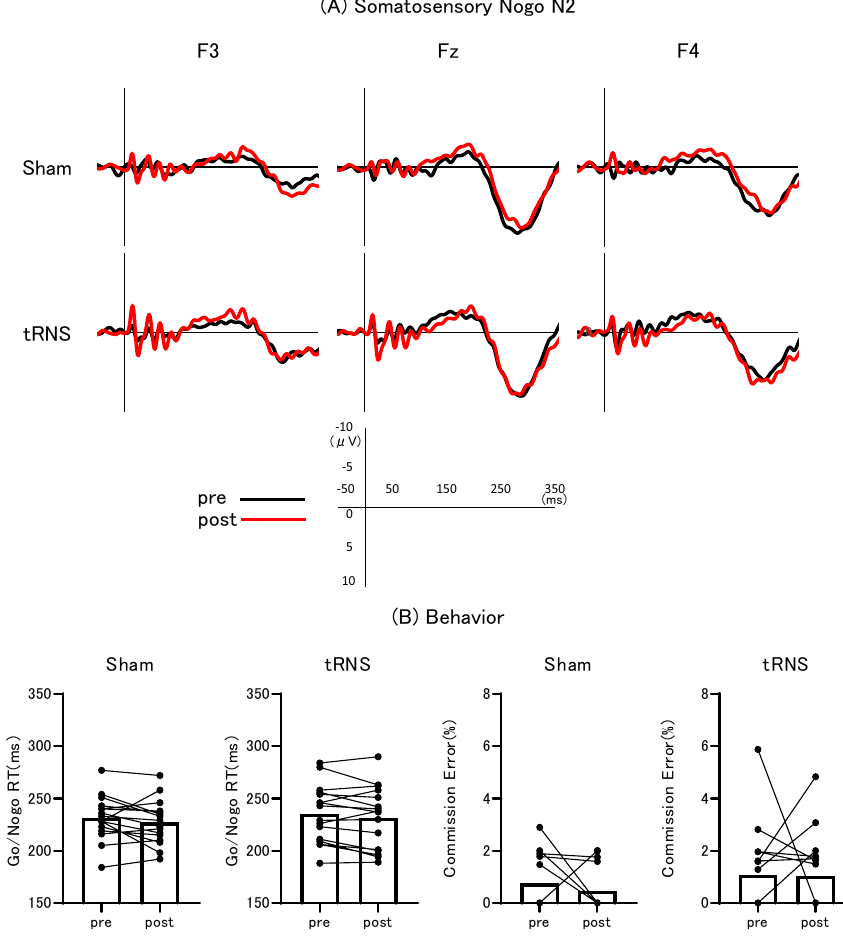
Figure 2. Grand-averaged somatosensory Nogo N2 waveforms and task performance. ( A ) Grand-averaged somatosensory Nogo N2 waveforms at electrode positions F3, Fz, and F4 before sham or tRNS (pre,